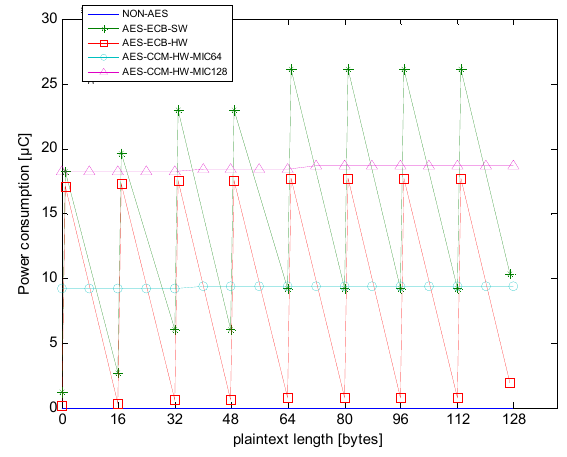
Figure 9. Additional power consumption of different encryption types.